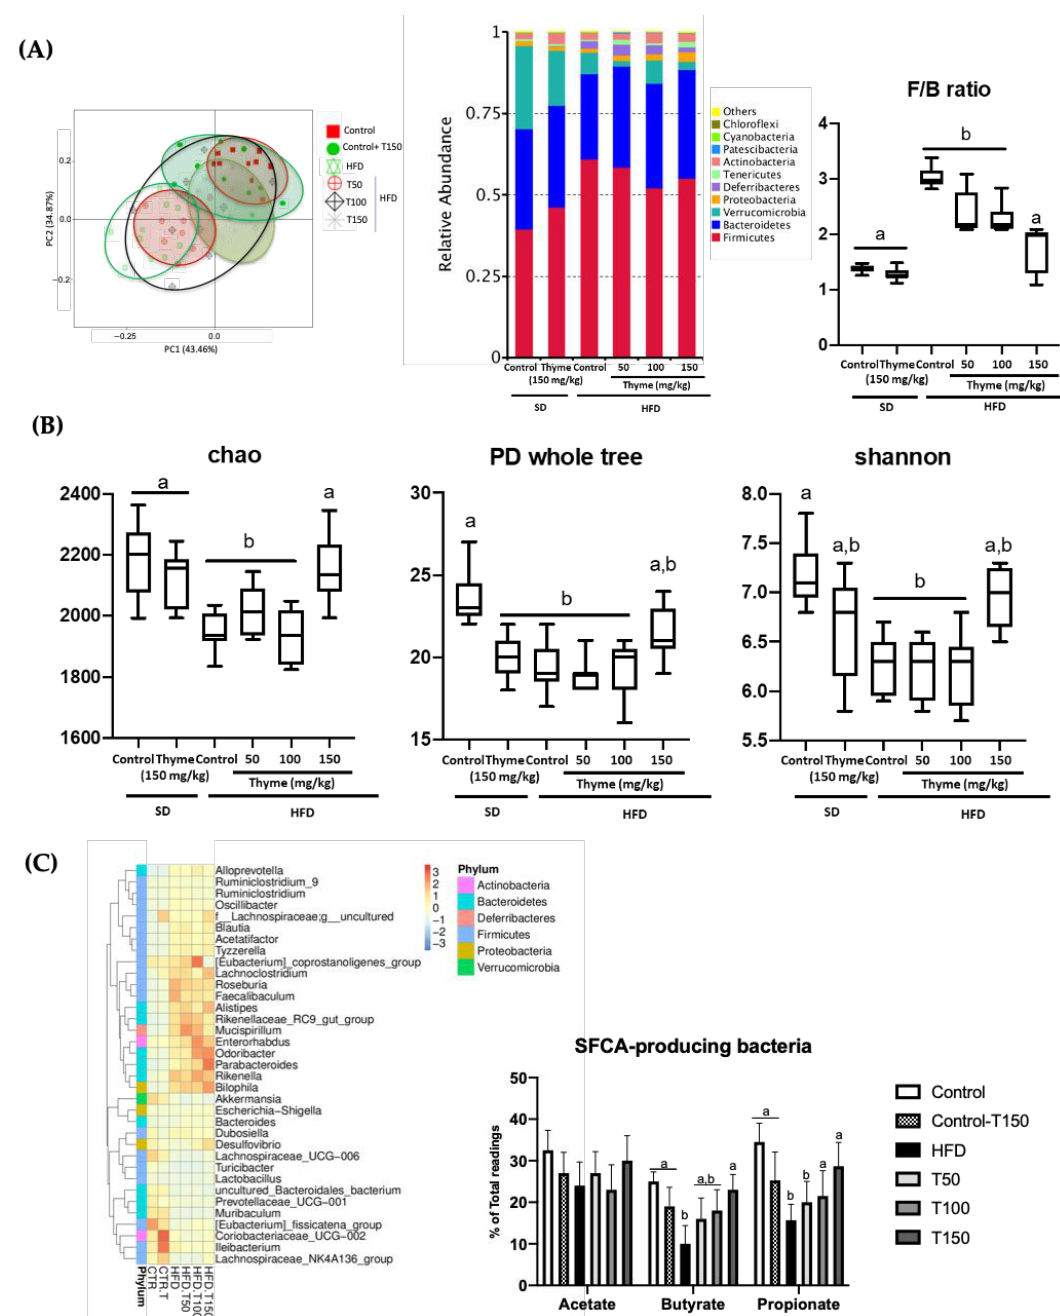
Figure 9. Effects of Thyme extract administration on: ( A ) Beta-diversity by principal coordinate analysis score plot, bacterial community (phyla, class and genus) and the F/B ratio; ( B ) microbiome diversity (Chao1, PD whole tree and Shannon index) and ( C ) short fatty chain acids (SCFA) production by each group of mice. Data are expressed as means ± SEM ( n = 10). Groups with different letters statistically differ ( p < 0.05).